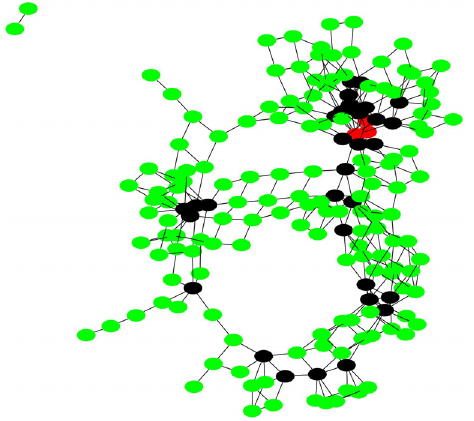
Figure 4. A clique intersection graph for a large microarray